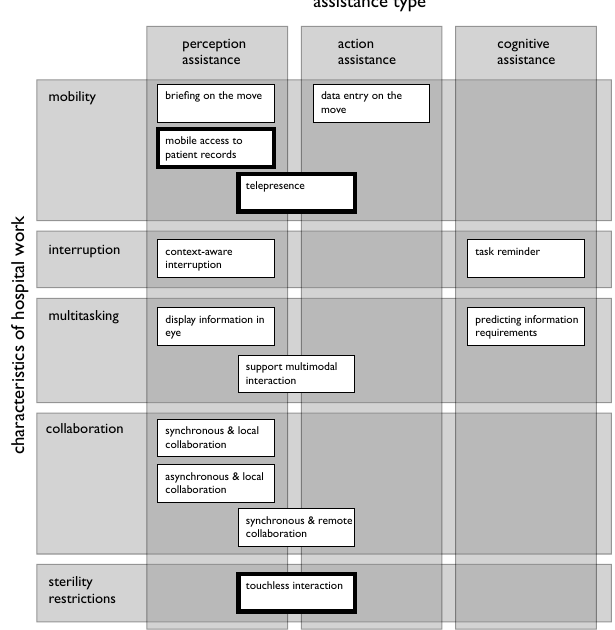
Figure 2. A design framework for Wearable Personal